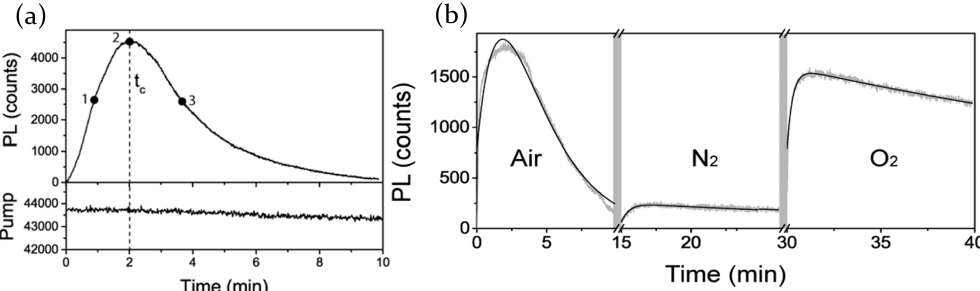
Figure 5. ( a ) Temporal evolution of PL intensity maximum at 775 nm for MAPbI 3 perovskite films, under monochromatic light excitation (500 nm), showing an initial photoactivation stage followed by intensity quenching after t c . ( b ) Evolution of the PL peak intensity when switching the atmosphere from air to nitrogen and then to pure oxygen. Adapted with permission from [65]. Copyright © 2015, American Chemical Society. https://pubs.acs.org/doi/10.1021/acs.jpclett.5b00785. Further permission should be directed to the